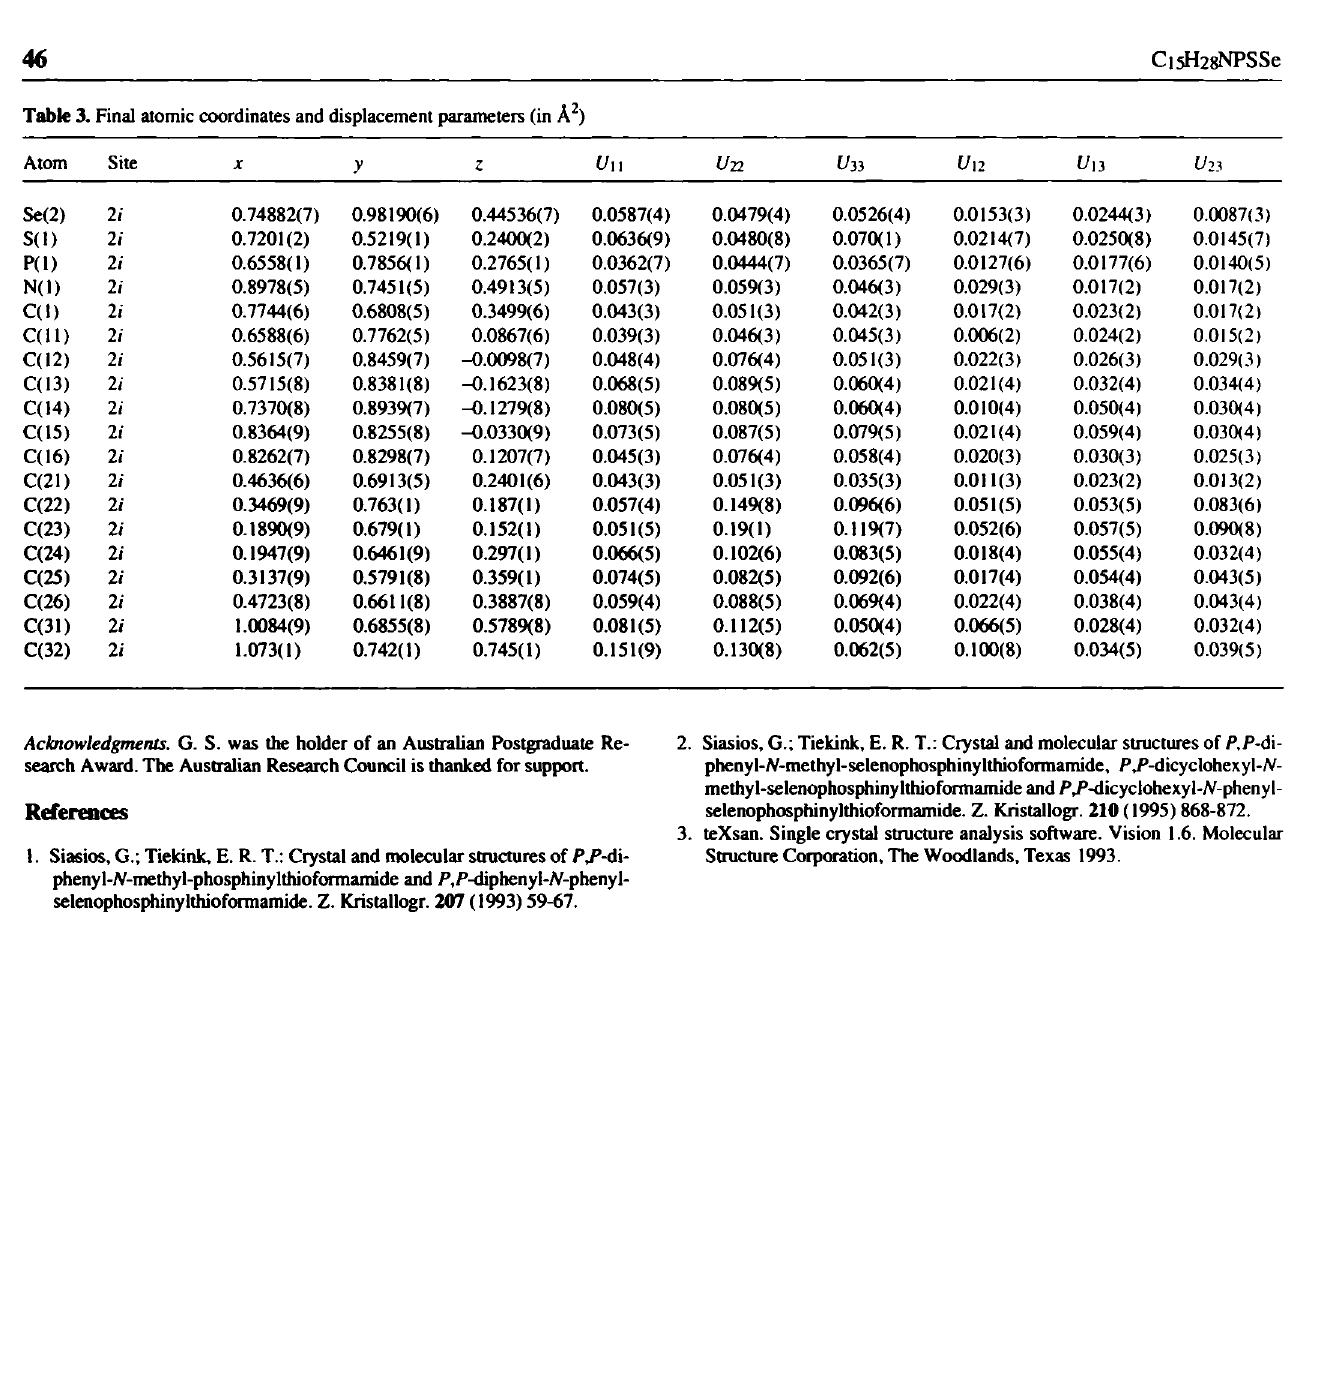
Tabk 3. Final atomic coordinates and displacement parameters (in